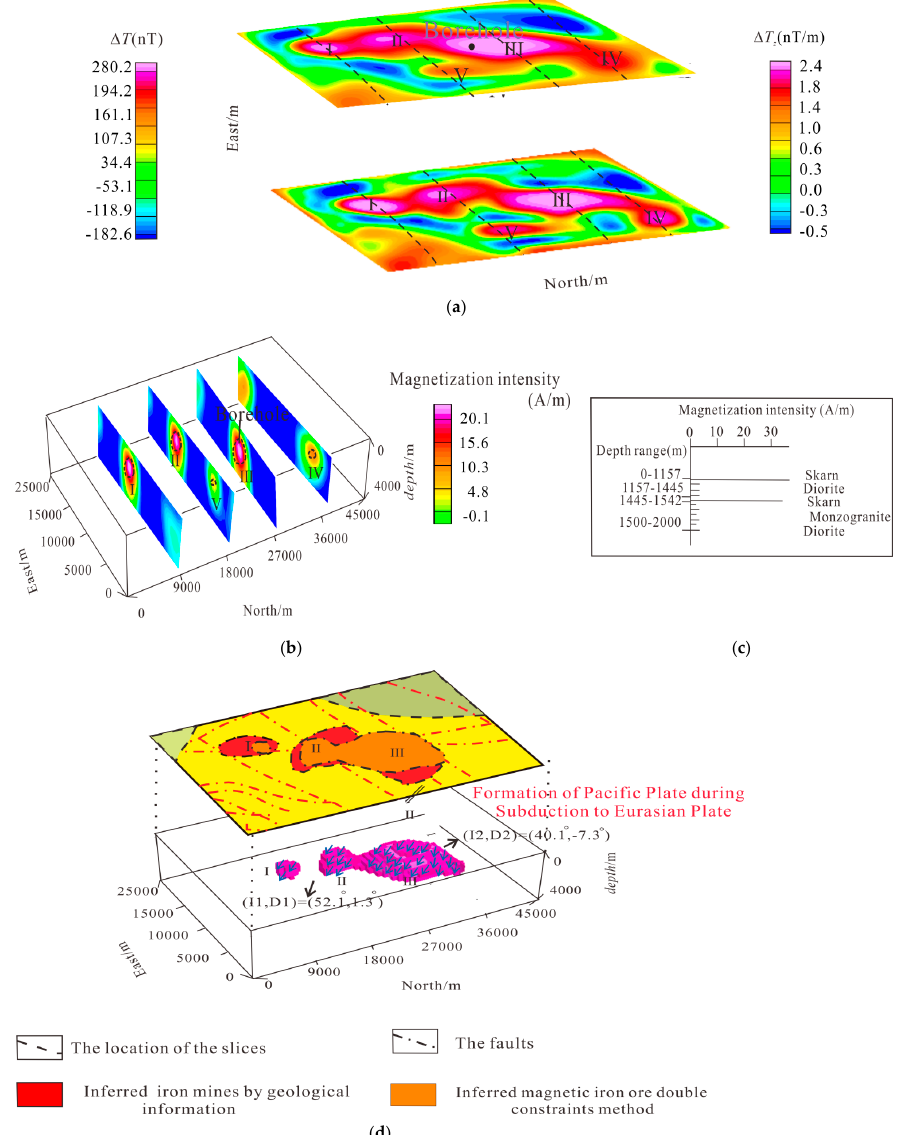
Figure 10. The results of magnetic data and CMG data by the double constraint method in the sur- vey area. ( a ) The locations of the boreholes, airborne magnetic anomaly and gradient anomaly; ( b ) slices of the double constraints inversion results of airborne magnetic data and CMG data; ( c ) mag- netization intensity of rock exposed by borehole; and ( d ) the range of high-magnetic bodies inferred, and the 3D magnetization vector view and magnetization intensity larger than 12.8 A/m.